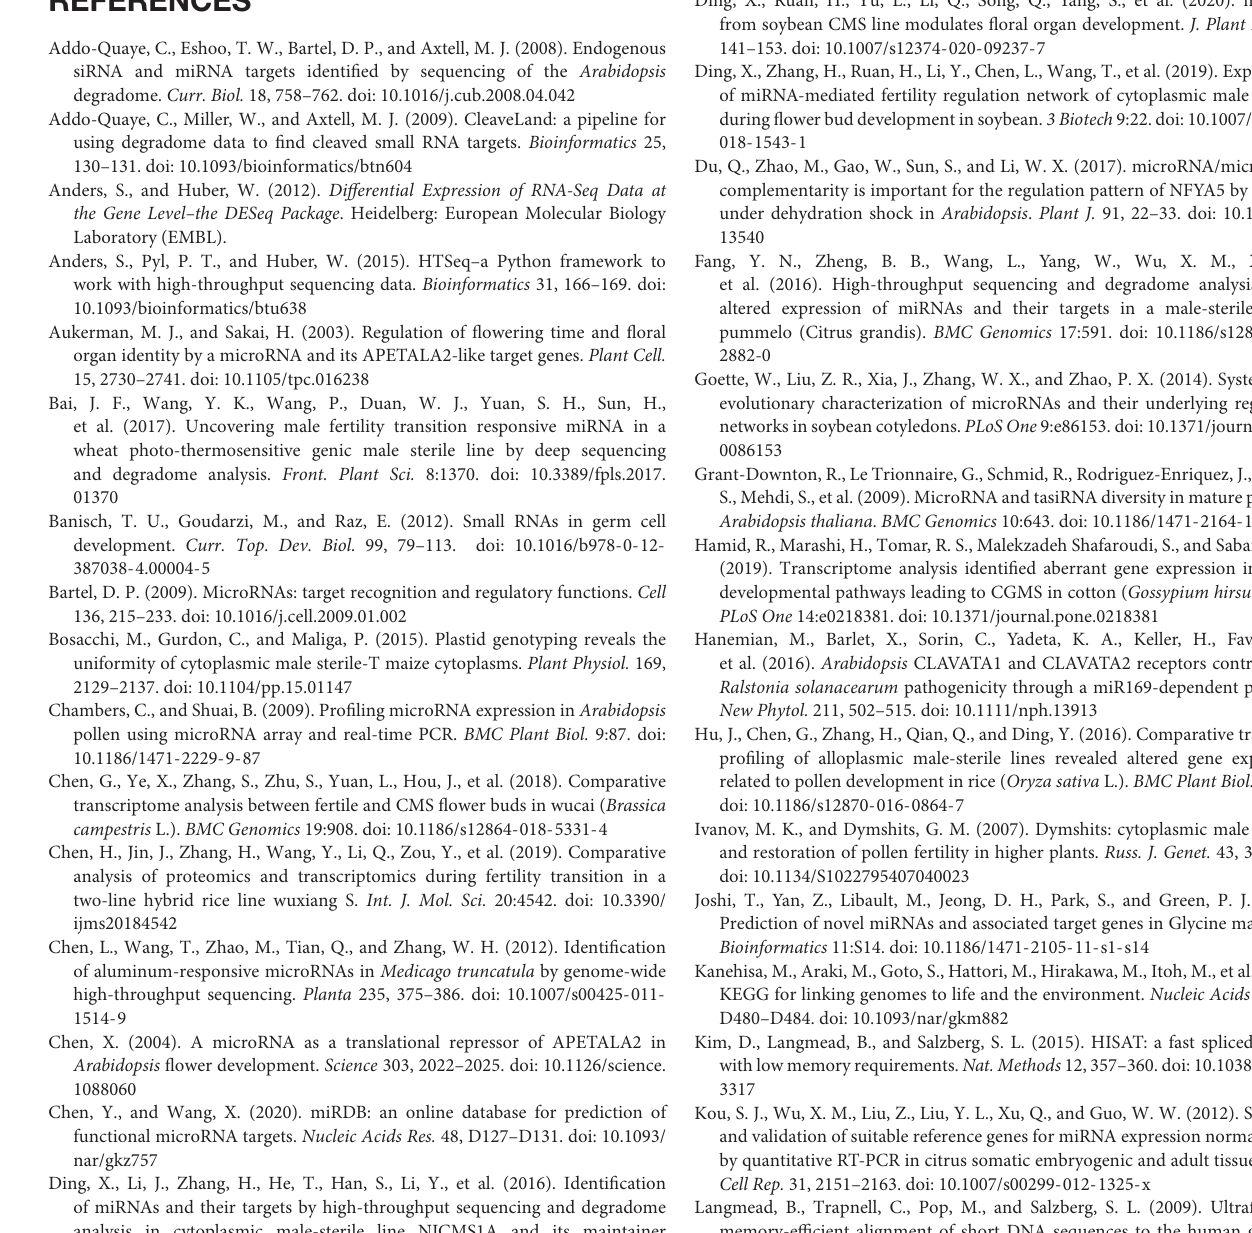
Supplementary Figure 3 | Number of identified conserved microRNAs (miRNAs). Supplementary Figure 4 | Detection of selected miRNAs expression in JLCMS9A and JLCMS9B using q-RT-PCR. U6 was chosen as an endogenous control. The reulsts were obtained from three biological replicates with three technical replicates and the error bars indicated the standard error of the mean. Supplementary Table 1 | Overview of small RNA sequencing reads from raw data to clean reads. Supplementary Table 2 | Summary of known and predicted microRNAs (miRNAs) in this study.